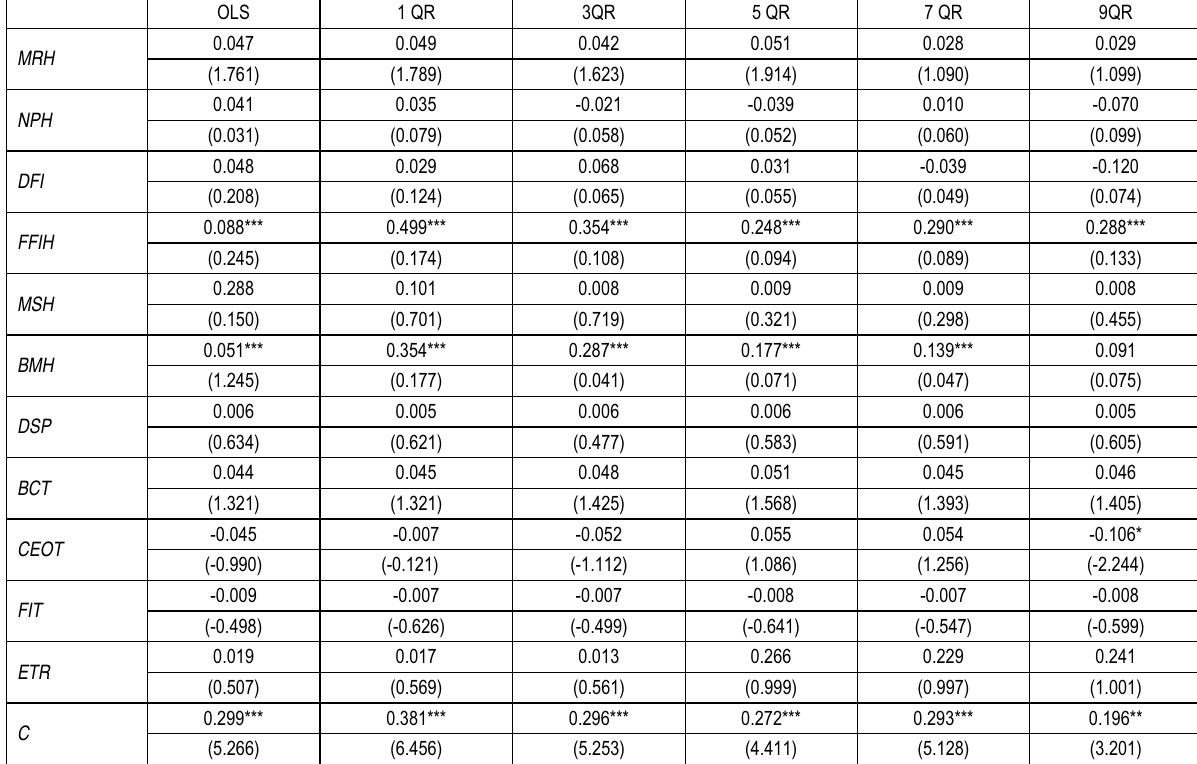
Table 5. The results of quantile regression on return of equity ( ROE )